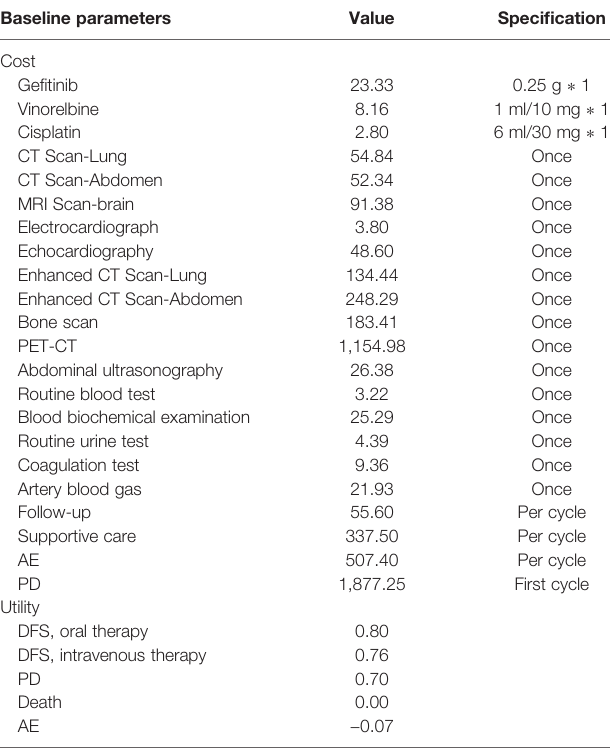
TABLE 2 | Baseline parameters. Baseline